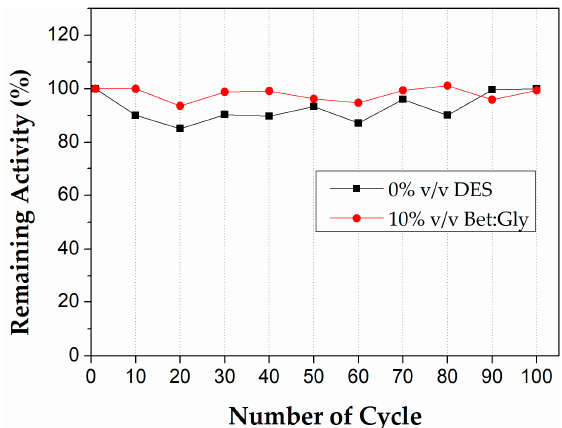
Figure 8. Operational stability of immobilized CALB in PLA microreactors in the absence and the presence of 10% v / v Bet:Gly for 100 cycles of use. Reaction conditions: 0.25 mM pNPB in 50 mM phosphate buffer pH 7.5, 0 or 10% v / v Bet:Gly, 40 °C, flow rate 300 μ L/min ( t R = 30 sec).